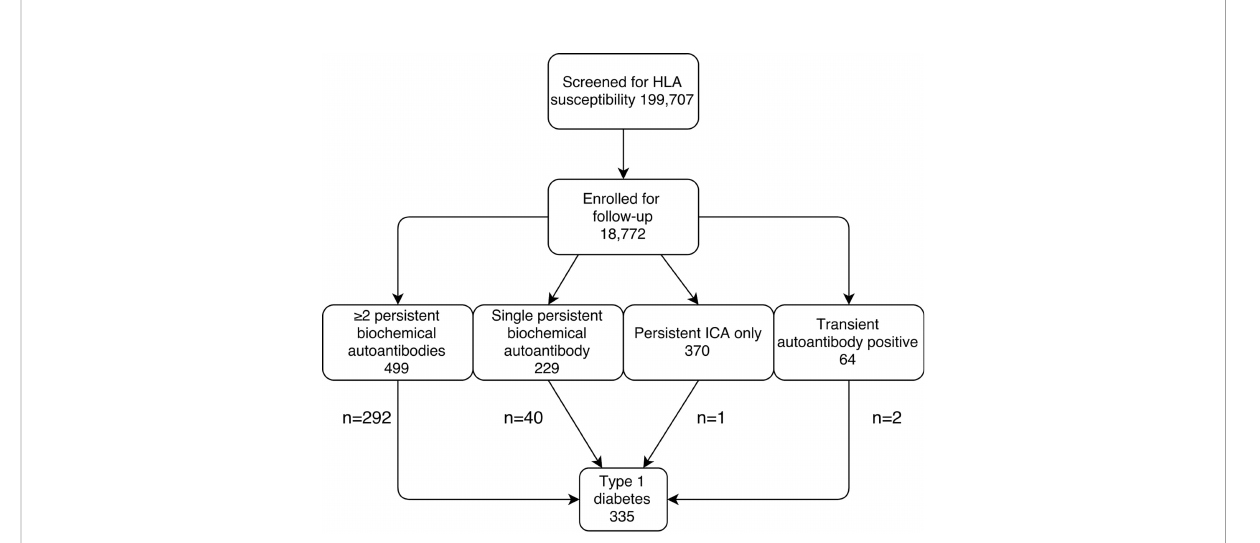
FIGURE 1 Flow-chart for the identi fi cation of the current study groups. The follow-up ended on August 31,